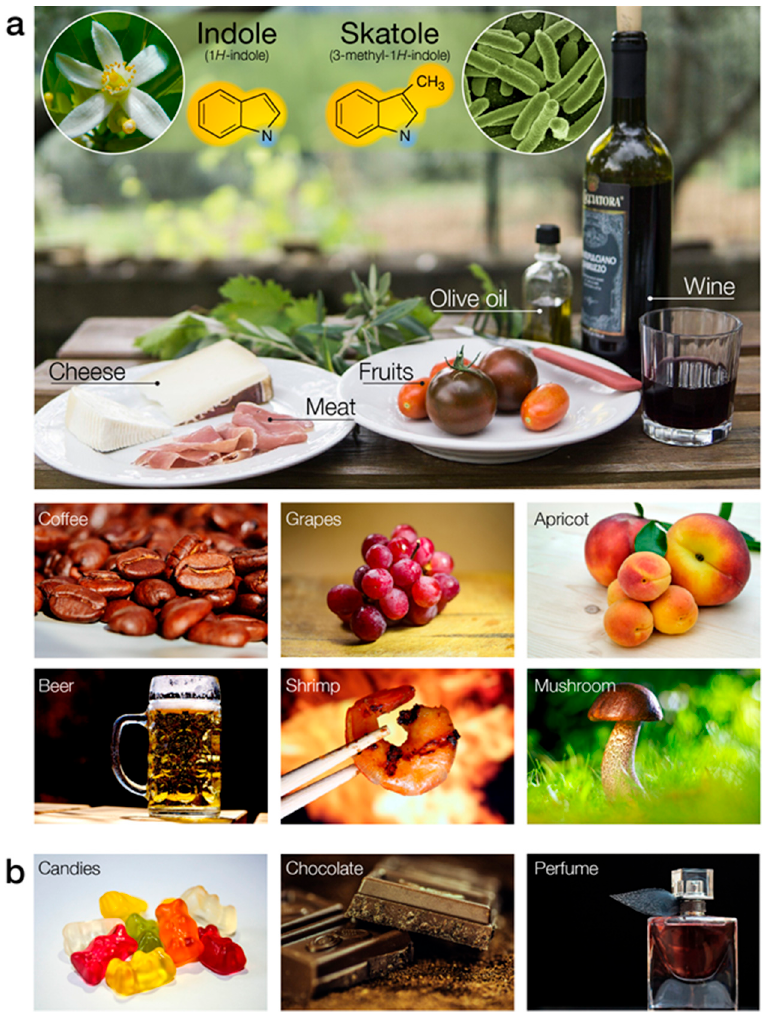
Figure 5. Biogenic origins and occurrence of indole and skatole. ( a ) Indole and skatole are synthesized by the shikimate pathway in plants and by bacterial tryptophan catabolism. These two indolics exhibit a dominant hydrophobic ring system and carbon-hydrogen bonds over a hydrophilic center (N atom). These compounds are naturally occurring in a wide variety of food items (e.g., cheese, meat wine, coffee, grape, apricot, beer, shrimp, mushroom). ( b ) Indole and skatole are used in flavor (e.g., fruity-flavored candies, chocolate) and perfume compositions.